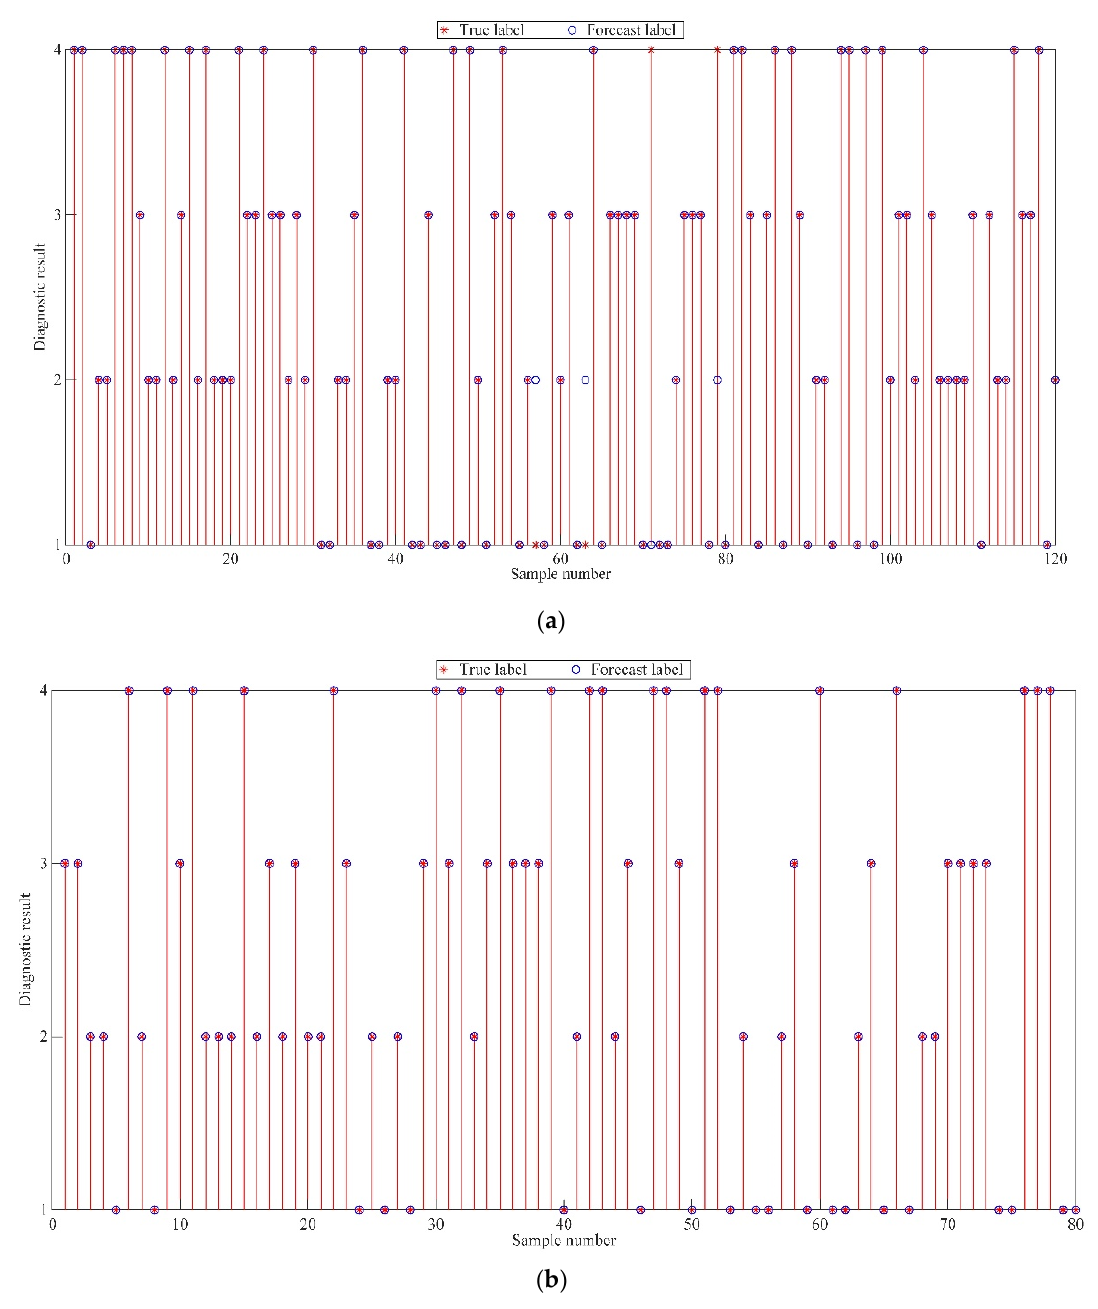
Figure 15. Diagnostic results of different samples, ( a ) training samples, ( b ) test samples. Table 7. Diagnostic error types of different